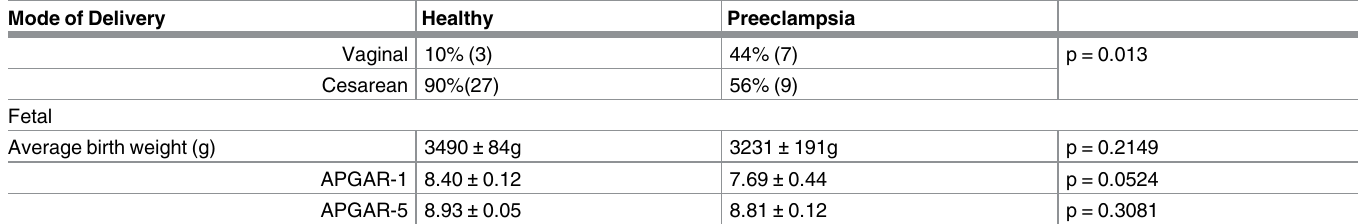
Table 2. Subject obstetrical characteristics for immunophenotype. Mode of delivery differences analyzedusing a Fisher’s exact test. Fetal birth weight and APGAR score differencesanalyzedusing a two-way student’s T